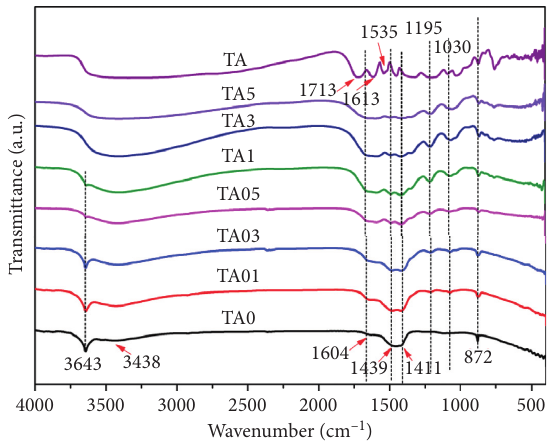
Figure 2: FTIR spectra of CH precipitates and TA.